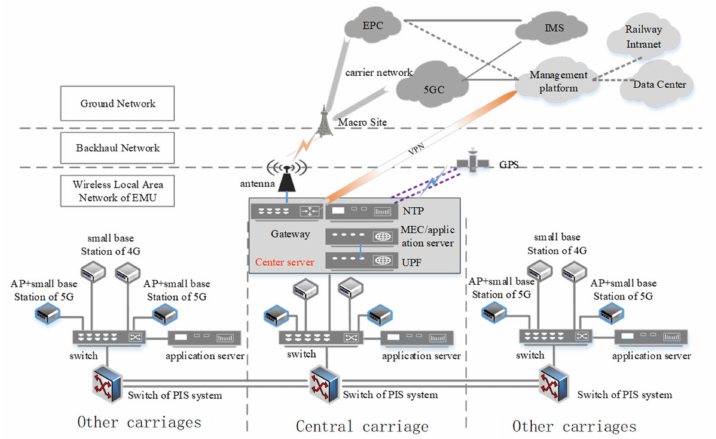
Figure 4. Overall network